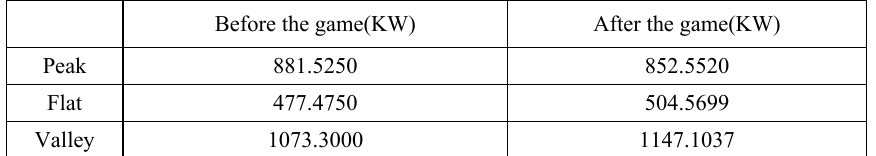
Table 2. Comparison of daily electricity consumption in peak and valley period before and after the game. Before the game(KW) After the game(KW) Peak